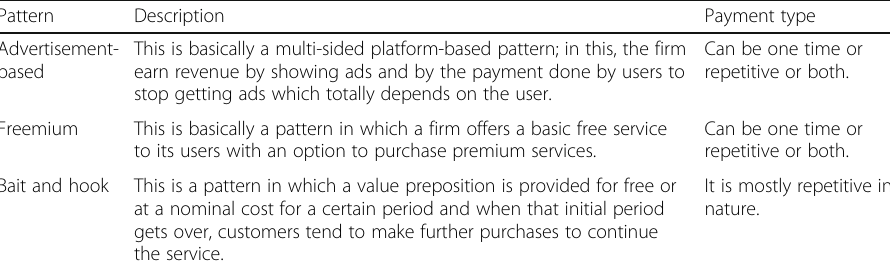
Table 3 Patterns of free business model (Brynjolfsson, 2010, Hofmann et al., 2010, Chaffey et al., 2015, Agostinho, 2016, Laudon et al., 2016, Lamberton et al.,